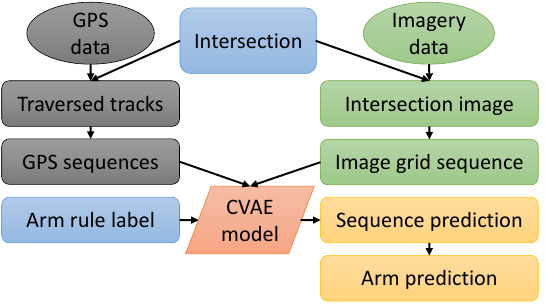
Figure 2. The workflow for arm rule detection using GPS and imagery data.